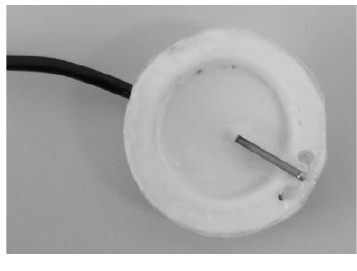
Figure 12. Detail of the MMG electrode.